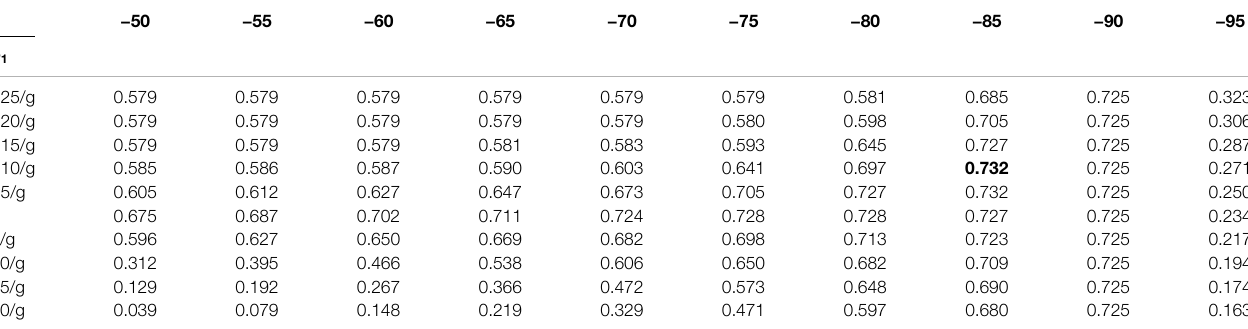
TABLE 2 | Variables and F-value (the bold value is maximum)..